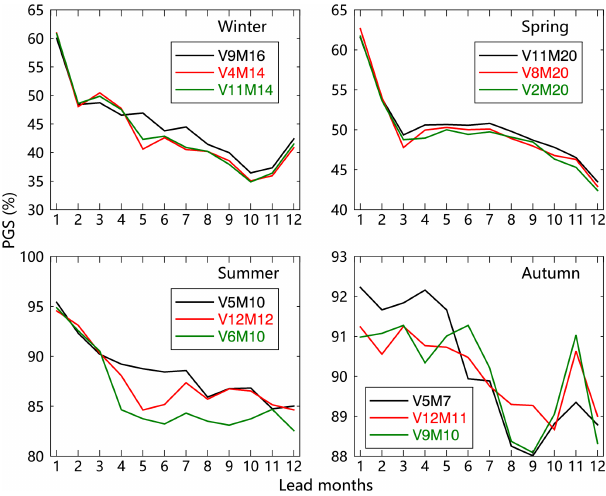
Figure 4. PGS for the preliminary selection of superior models in each season.